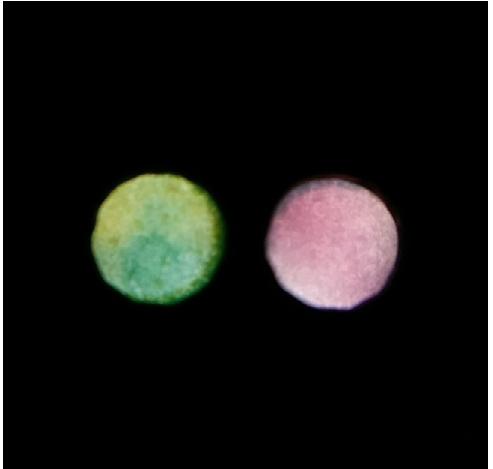
Figure 4. An exemplary photo obtained for simultaneous protein (left detection zone) and creatinine (right detection zone) determination.